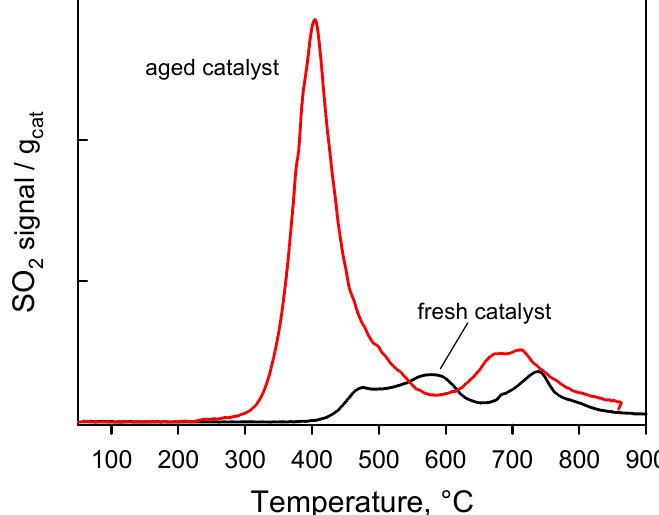
Figure 5. Comparison of SO 2 TPD for the fresh and 18 kh reaction-aged catalyst.